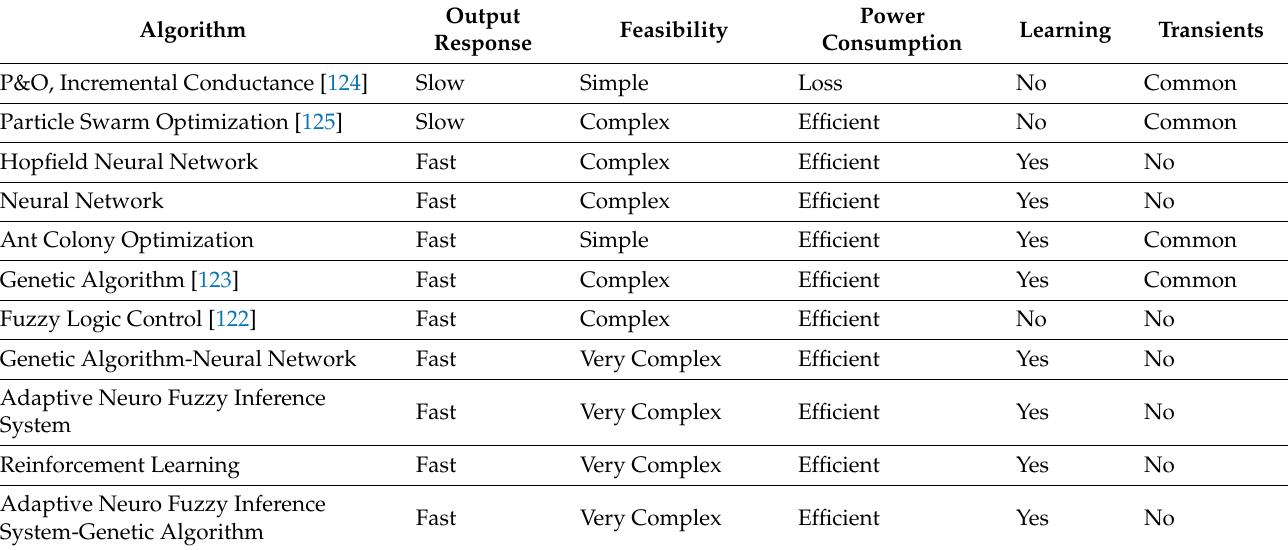
Table 8. Analysis of maximum power point tracking techniques in the